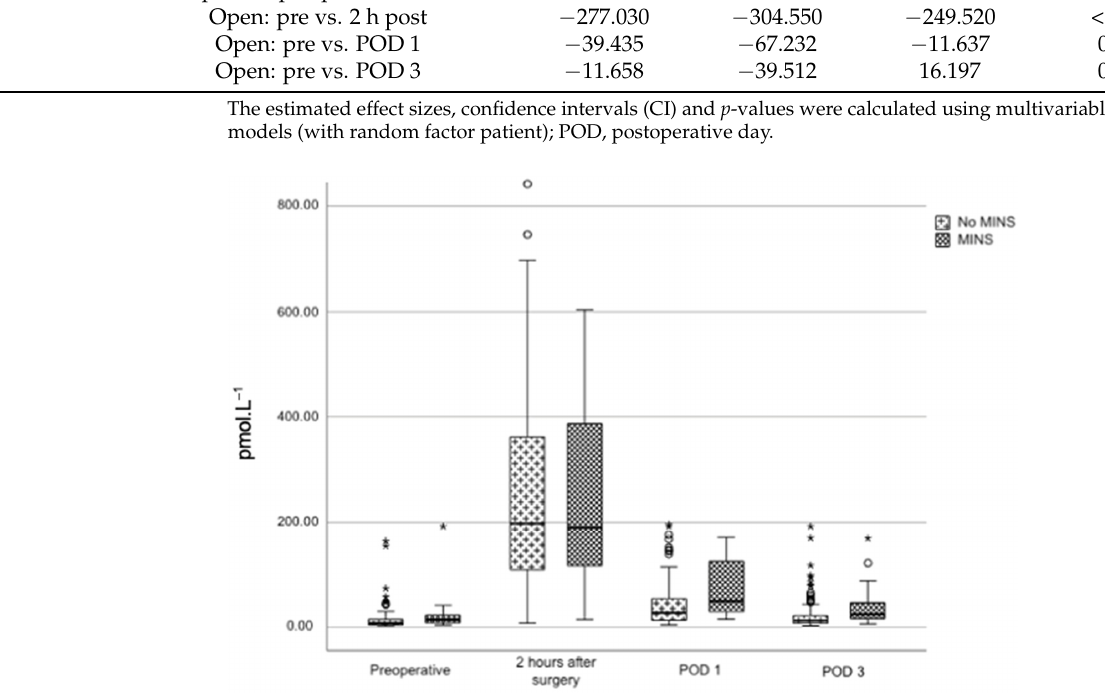
Figure A1. Boxplots showing the perioperative trend of Copeptin concentrations between patients with MINS and patients without MINS. Boxplots demonstrate medians and interquartile ranges; circles represent outliers; stars represent extreme outliers; MINS, myocardial injury after noncardiac surgery; POD, postoperative day.